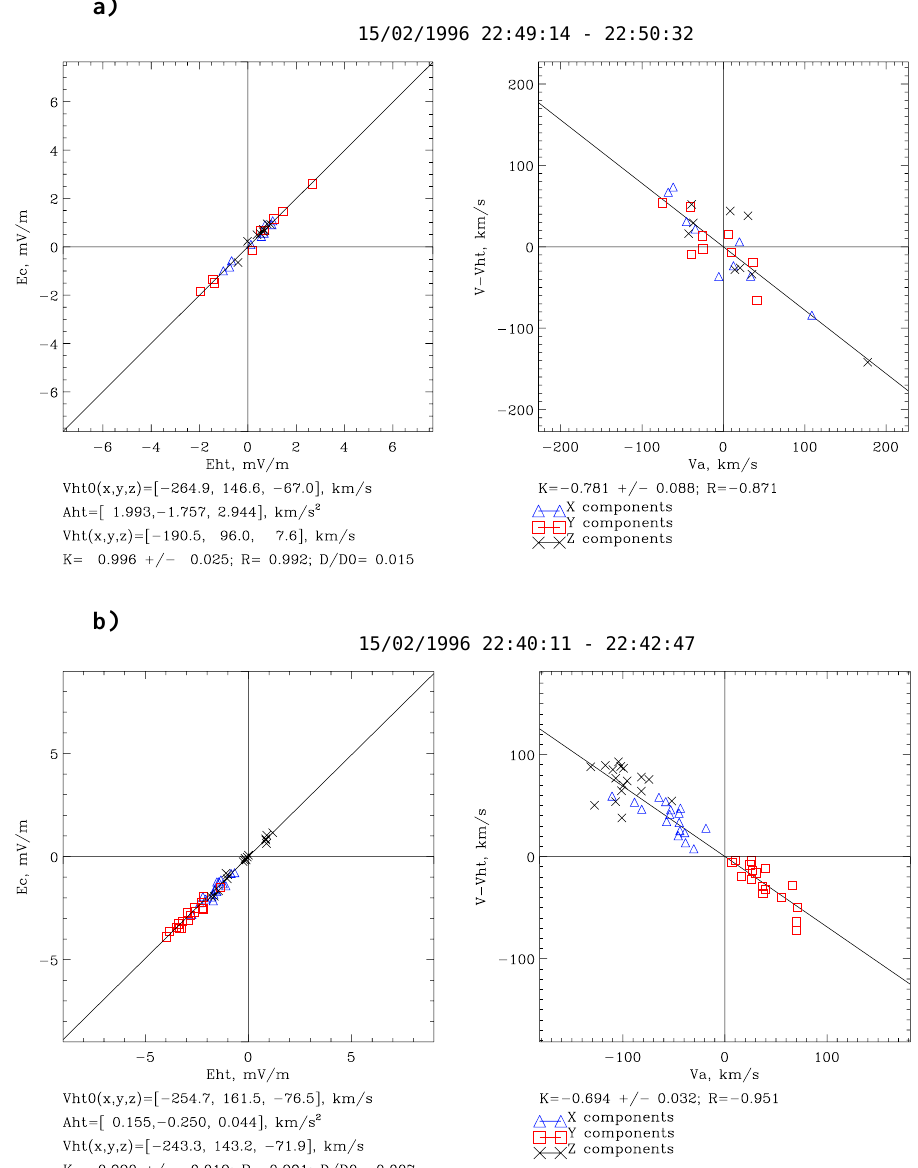
Fig. 5. Scatter plots (a) is for magnetopause crossing and (b) is for the magnetosheath region adjacent to the magnetopause. (Left) A component-by-component comparison is made of the convective electric field E c = − V × B versus electric field E HT = − V HT × B . The defined components of the HT and HT frame speed and acceleration in GSE are given. K and R are a slope and correlation coefficient between the convective electric field and E HT , respectively; (Right) Result of tangential stress balance referred to as Walen relations. K is a slope and R is correlation coefficient between the flow velocity in the HT frame and the corresponding Alfv´en velocity. Triangles, open boxes and crosses correspond to X , Y and Z components,